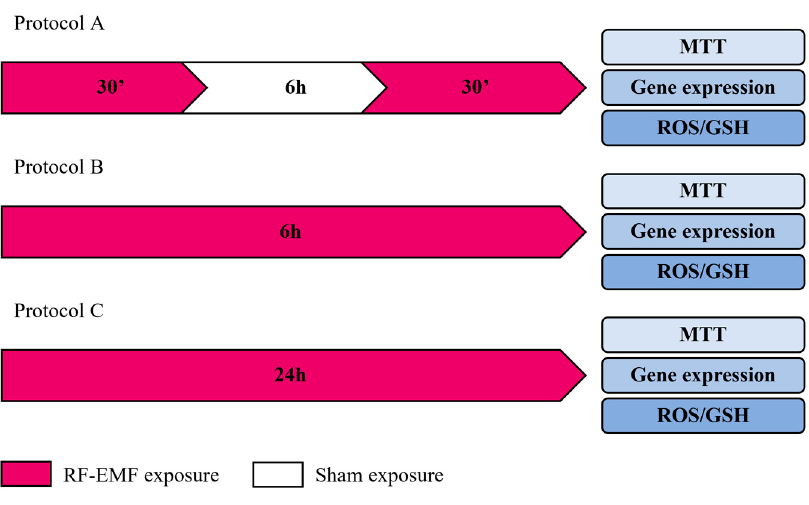
Figure 7. Experimental